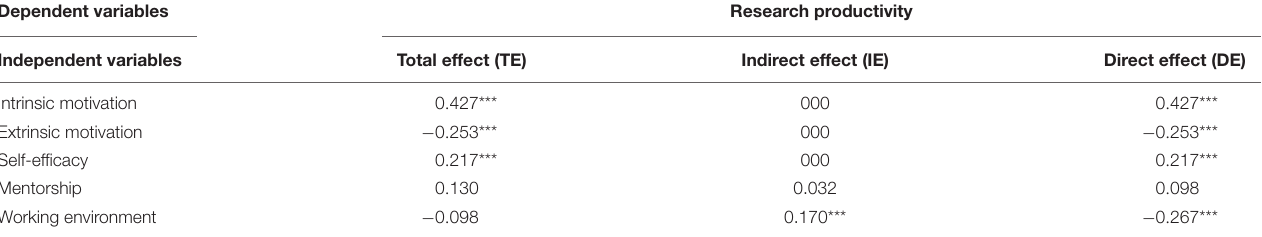
TABLE 14 | The statistical value of the effect analysis on research